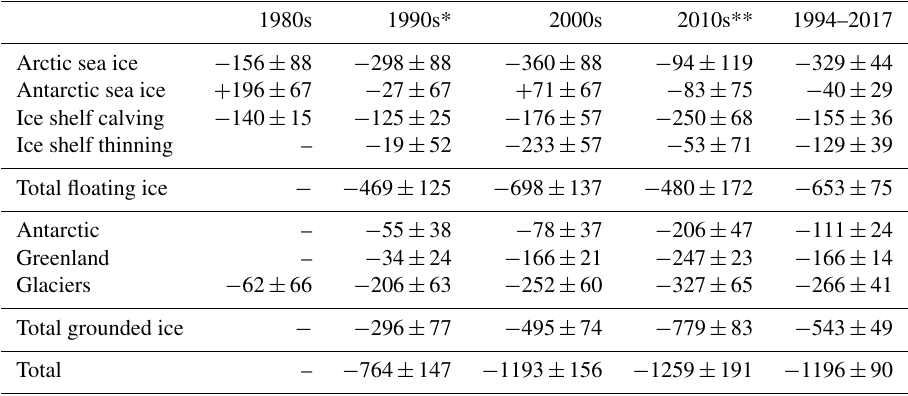
Table 1. Average mass change rates (Gtyr − 1 ) of the different global ice components, total floating ice, total grounded ice and global total per decade and over the common period